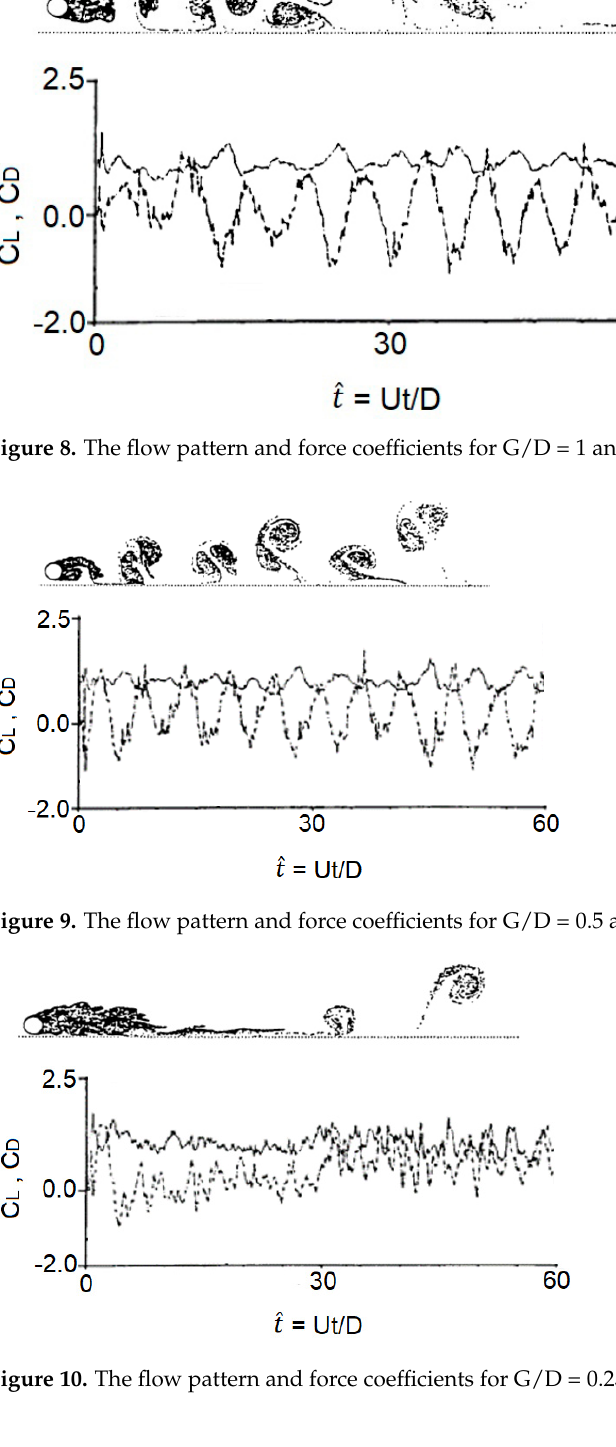
Figure 10. The flow pattern and force coefficients for G/D = 0.25 and Re = 100,000.